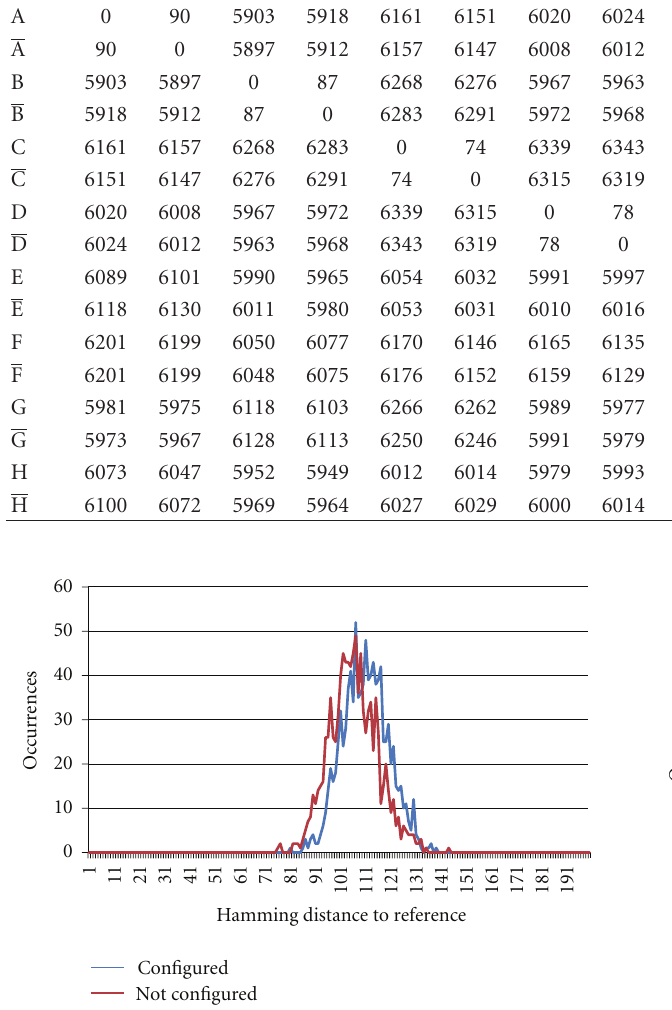
Table 3: Mutual Hamming distances of reference streams from unconfigured devices A ... G and configured devices A ... G. Device